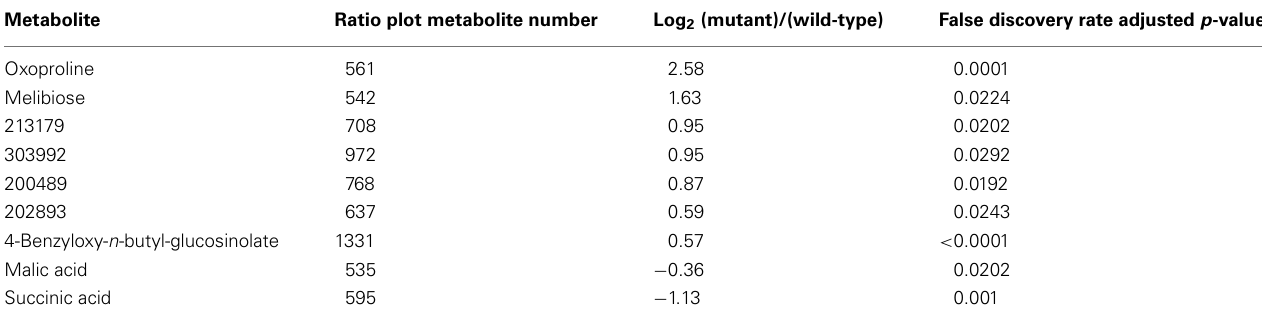
Table 3 | Metabolites significantly altered between oxp1 mutant (SALK_078745) and